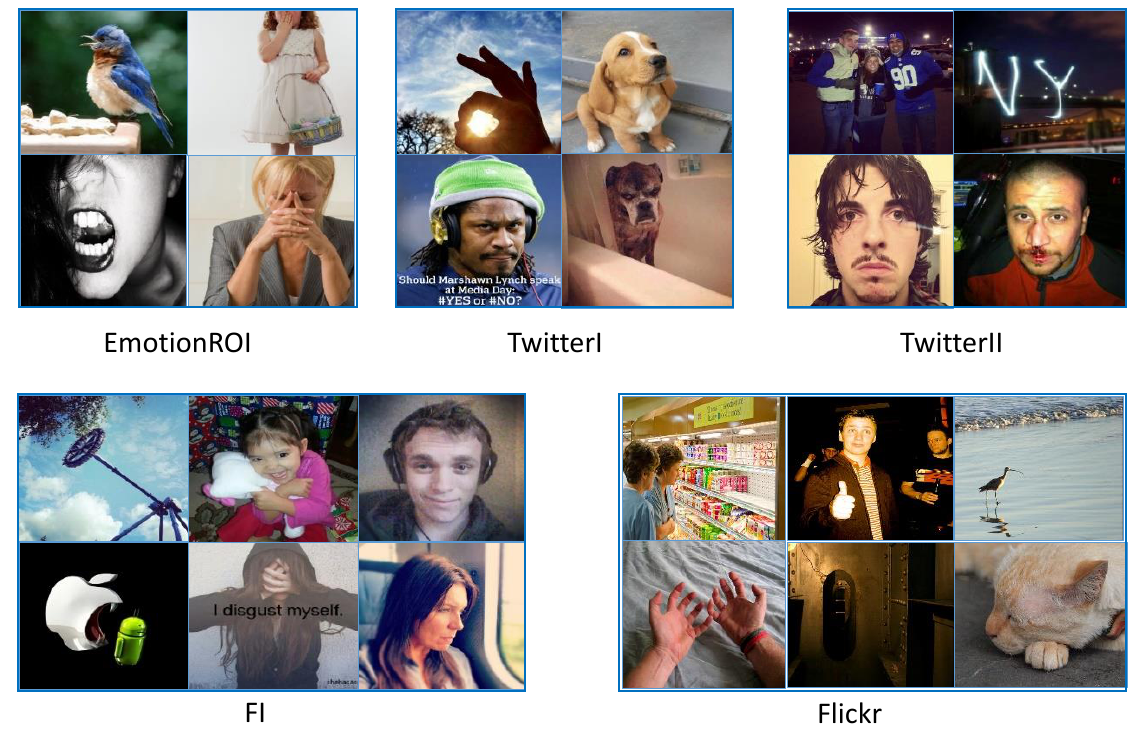
Figure 5. Some examples in the five